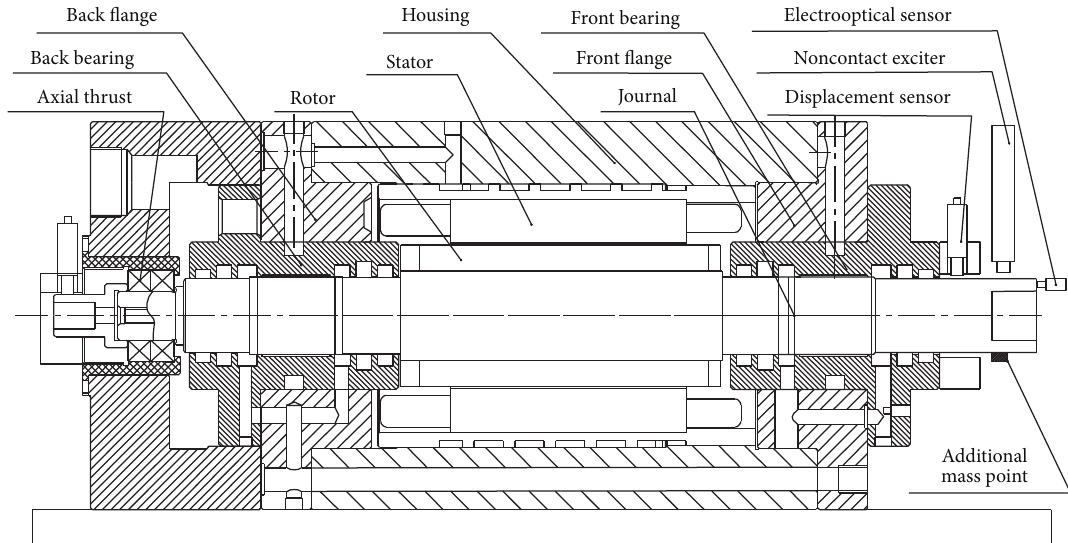
Figure 2: General view of the high-speed spindle